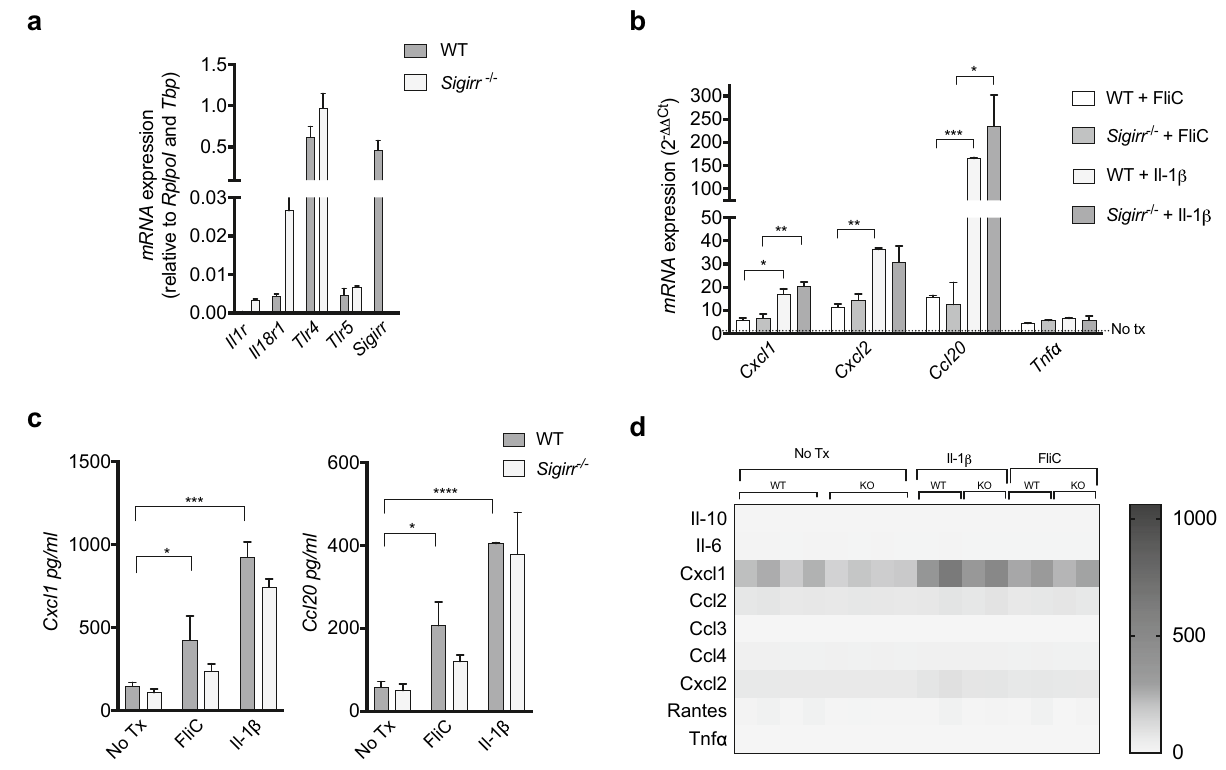
Figure 4. Mouse IEC responses to host (Il-1β) and bacteria stimuli (FliC). ( a ) qPCR analysis of innate receptor and negative regulator gene transcription by mouse colonoids expressed as relative expression over reference genes. ( b ) qPCR analysis of chemokines and cytokines after 4 h of stimulation with FliC and Il-1β expressed as fold change over untreated WT ( Sigirr + / + ) colonoid expression. ( c ) Cxcl1 (left) and Ccl20 (right) protein levels secreted basolaterally by colonoids derived from WT and Sigirr −/− mice after 4 h of stimulation with FliC or Il-1β. ( d ) Heat map representation of various chemokine concentration in the supernatant of colonoids after 4 h of stimulation with FliC or Il-1β. Mean and SEM are indicated. Mean and SEM are indicated from n = 4 mouse organoid lines derived from each genotype. All data shown are representative of at least 2–3 independent experiments. Statistical significance calculated using one-way ANOVA *, P = 0.01 to 0.05; **, P = 0.001 to 0.01; ***, P = 0.0001 to 0.001; ***, P = 0.00001 to 0.0001. Comparison lacking annotations are not